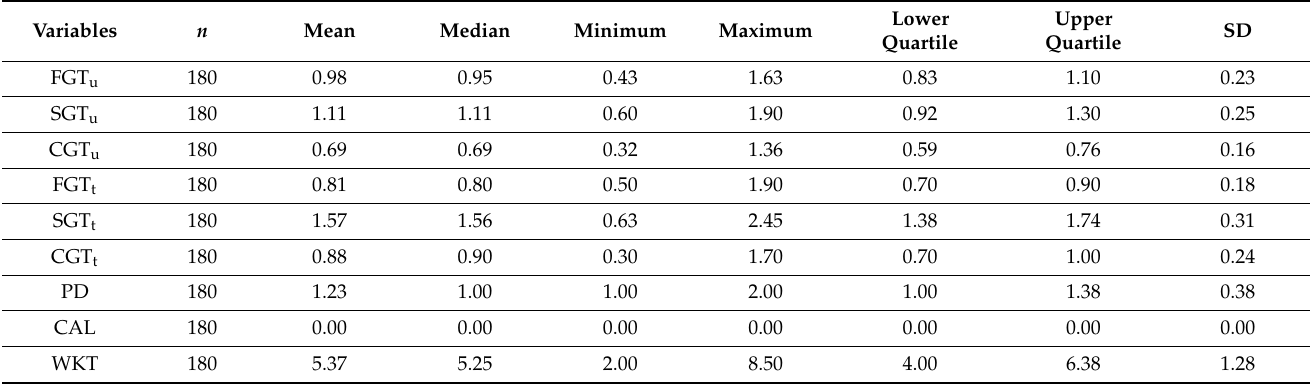
Table 1. Descriptive statistics of clinical and radiological measurements in millimeters (mm).